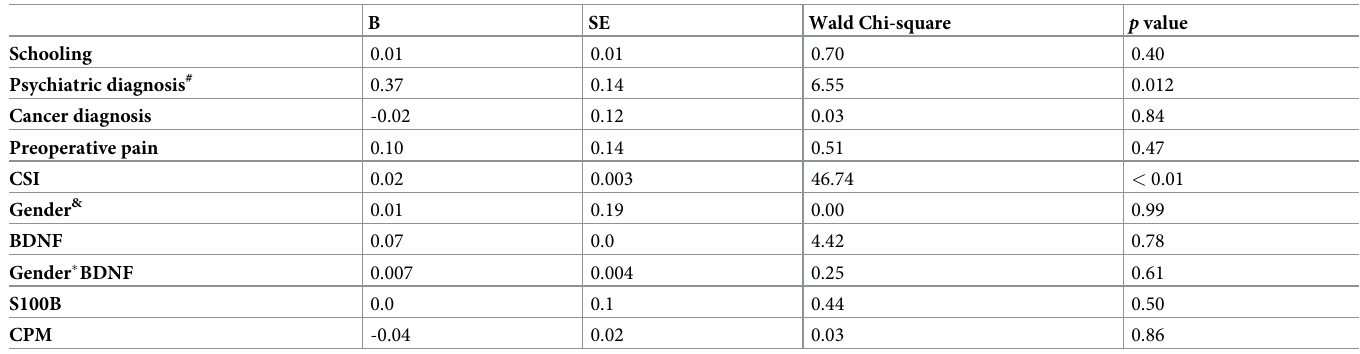
Table 4. Coefficients from generalized linear model of preoperative emotional stress (B-MEPS) and preoperative predictors. B SE Wald Chi-square p